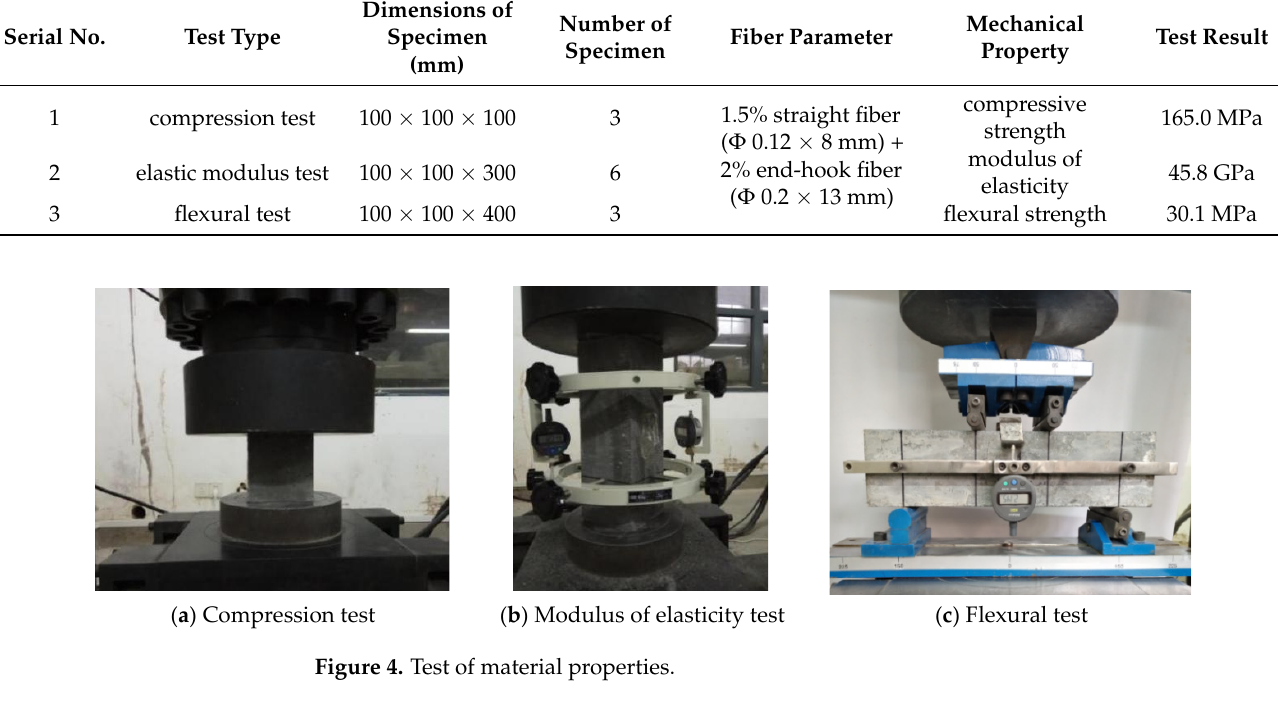
Figure 4. Test of material properties.